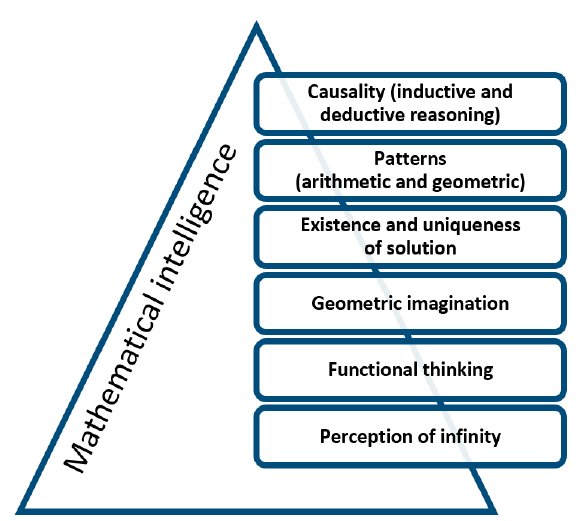
Figure 1. Mathematical intelligence and its elemental components.